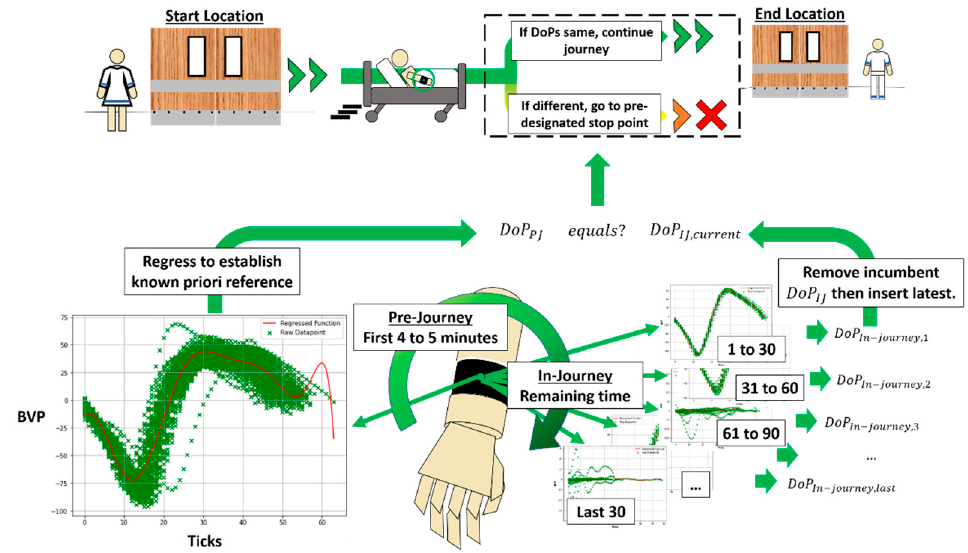
Figure 1. Schematic of photoplethysmography (PPG) remote automated monitoring (RAM) machine learning (ML) algorithm proposed for autonomous hospital bed transport.